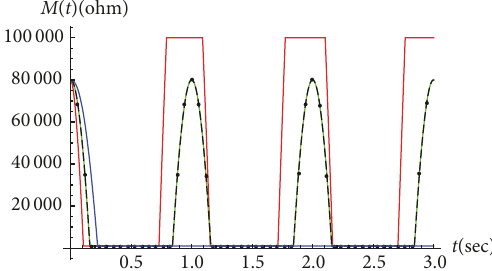
Figure 7: 𝑀(𝑡) of the boundary effect free fractional order memris- tor under the sinusoidal input with 𝐼 𝑚 = -110 𝜇 A and 𝛼 = 1.25